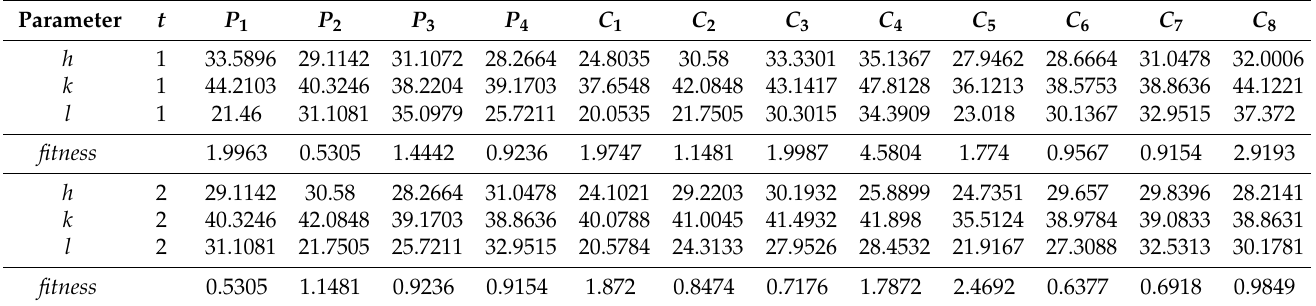
Table 1. Spherical model parameters generated via genetic algorithm for first and second